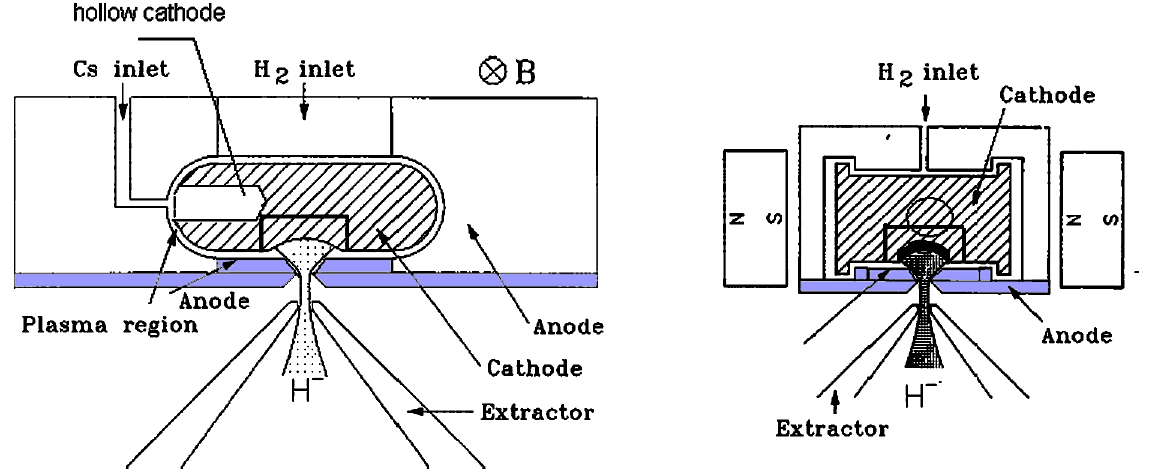
FIG. 1. Advanced version of magnetron with hollow cathode for suppression of discharge